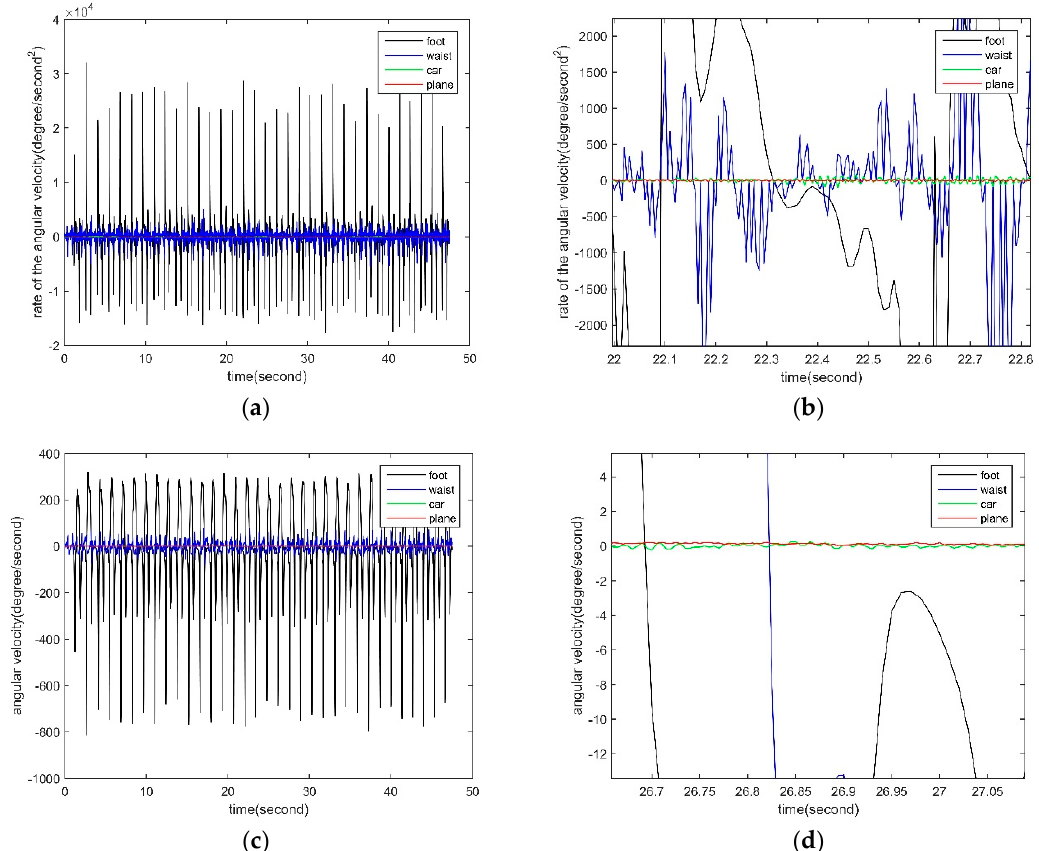
Figure A1. Angular motion data for different carriers. ( a ) Rate of angular velocity from four different carriers for car, plane, foot and waist; ( b ) Partial enlarged detail for ( a ); ( c ) Angular velocity from four different carriers for car, plane, foot and waist; ( d ) Partial enlarged detail for ( c